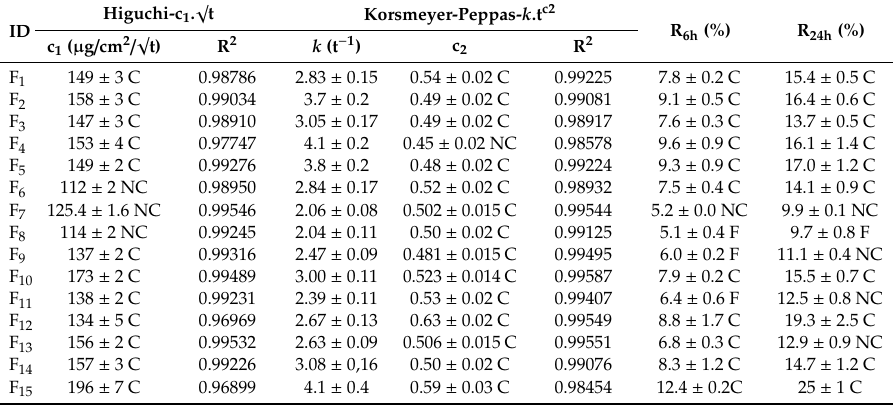
Table 7. Regression parameters resulting from the different rheological model fitting to the acquired rheological data.